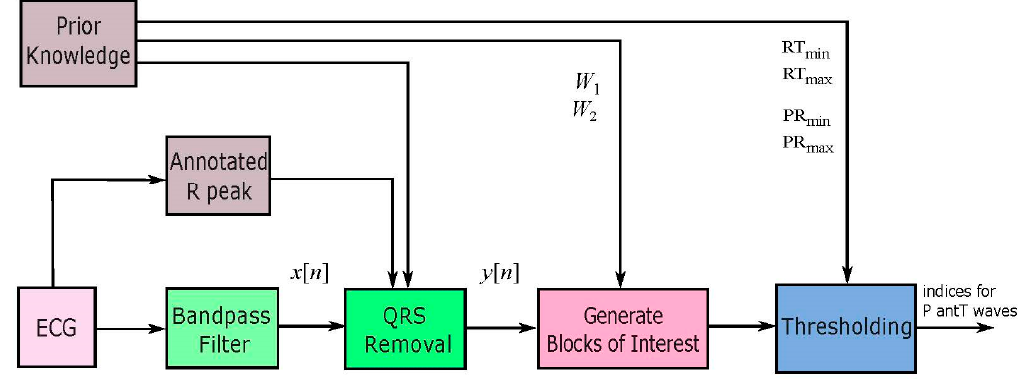
Figure 1. Structure of the proposed P and T waves detection algorithm.